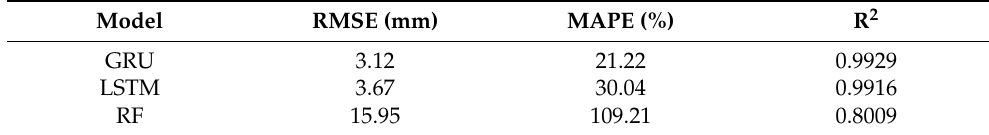
Table 2. Prediction accuracy of the trained models.